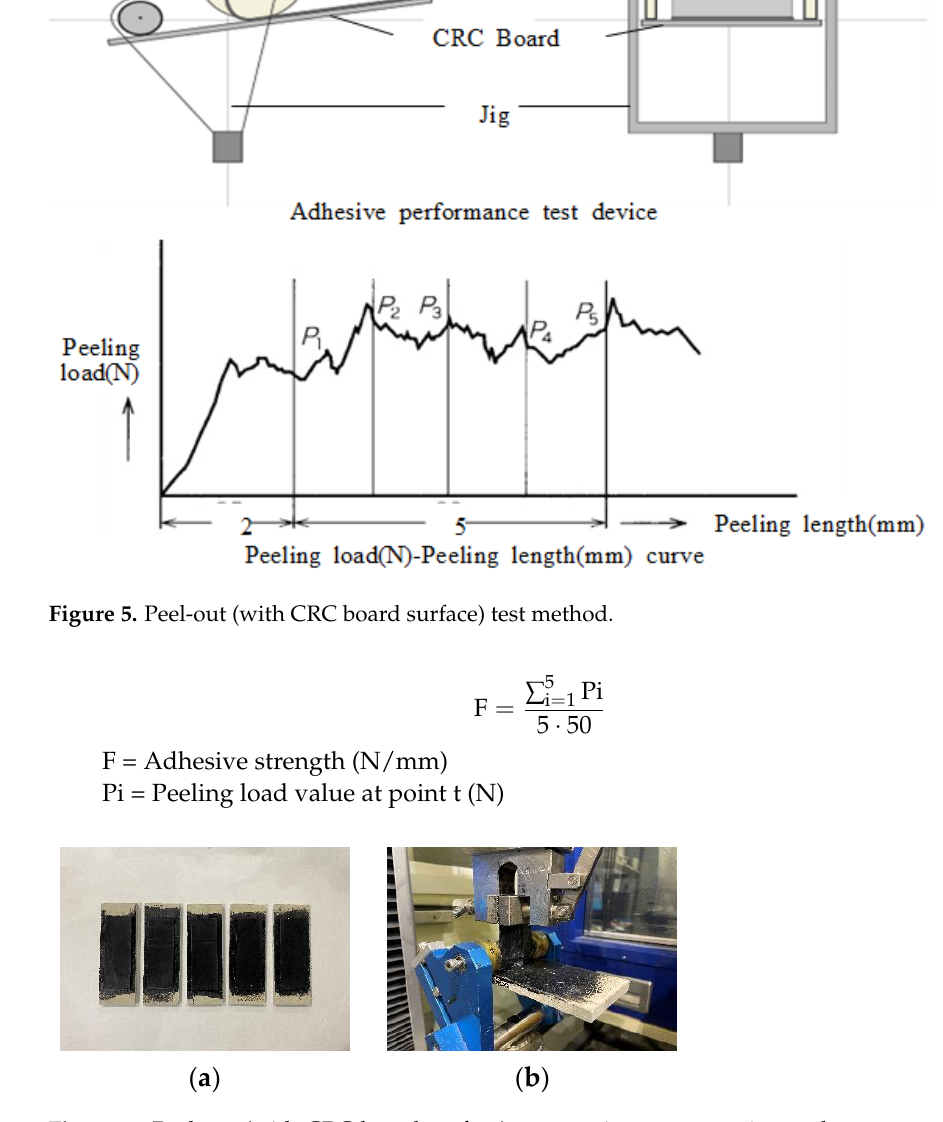
Figure 6. Peel-out (with CRC board surface) test specimen preparation and test status. ( a ) Test prep- aration; ( b ) Test status.